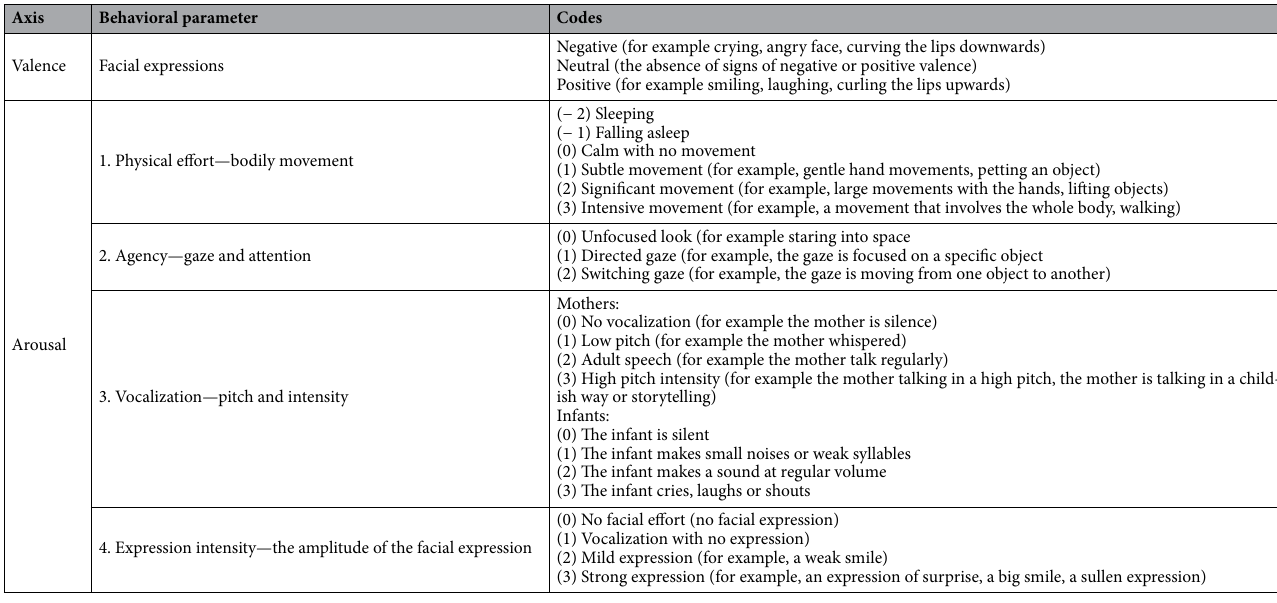
Table 1. ARCS—affect regulation coding